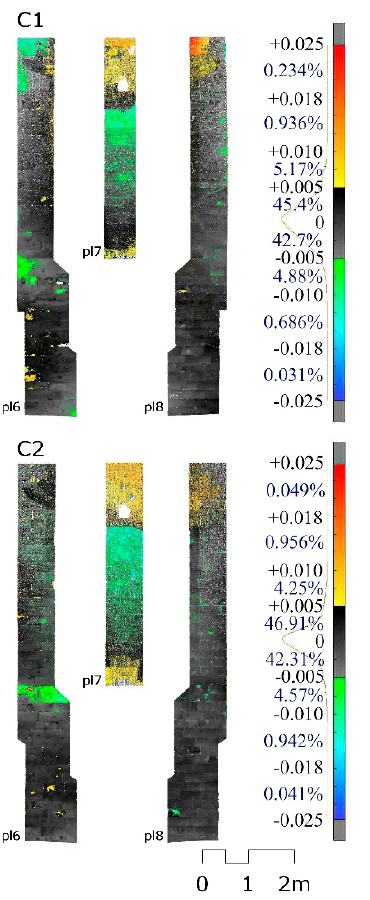
Figure 13: Flatness study of the walls of the upper buttresses.